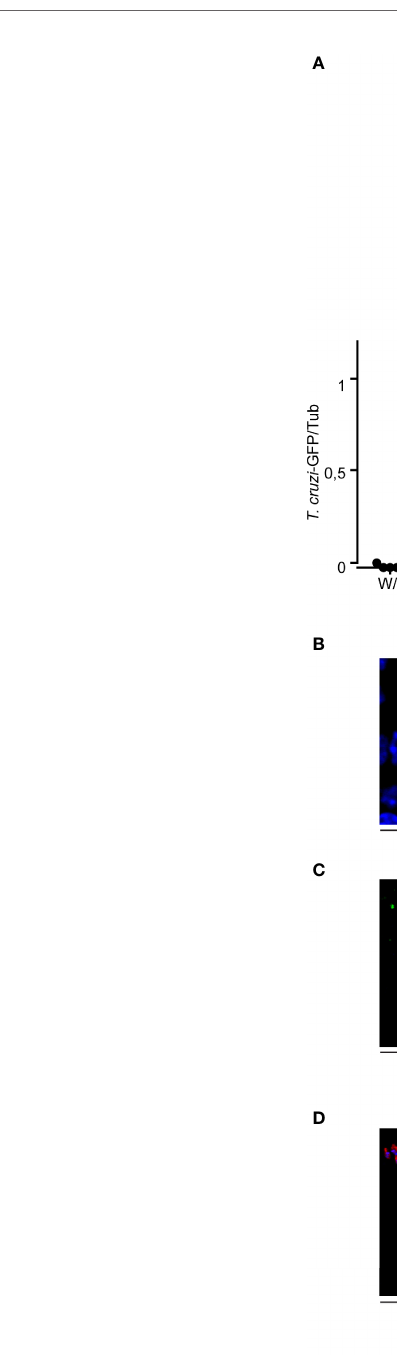
FIGURE 1 | Effect of UA on the number of intracellular amastigotes. RAW macrophages, BMM, or H9C2 cells infected with Trypanosoma cruzi Y or Y-GFP strain (MOI = 10) for 24 h and then treated for additional 24, 48, or 72 h under different conditions. (A) Representative immunoblots are depicted. Densitometry was performed using NIH ImageJ. We calculated the GFP/TUBULIN. Data represent the mean ± SEM of fi ve independent experiments. (B) Confocal images showing amastigotes of T. cruzi (red) in RAW macrophages under the indicated conditions. Scale bars, 10 m m. Quanti fi cation of the number of amastigotes per cell. Data represent the mean ± SEM of three independent experiments (number of counted cells ≈ 100). *p < 0.05, Tukey ’ s test. (C) Confocal images showing amastigotes of T. cruzi (Green) in BMM under the indicated conditions; here we used 5 µM of UA. Scale bars, 10 m m. Quanti fi cation of the number of amastigotes per cell. Data represent the mean ± SEM of at least three independent experiments (number of counted cells in each experiment ≈ 100). **p < 0.01, Tukey ’ s test. (D) Confocal images showing amastigotes of T. cruzi (red) H9C2 under the indicated conditions at 48 h of treatment. Scale bars, 10 m m. Quanti fi cation of the number of amastigotes per cell at 24 h of treatment. Data represent the mean ± SEM of at least three independent experiments (number of counted cells ≈ 100). UA, ursolic acid; BMM, bone marrow macrophage; MOI, multiplicity of